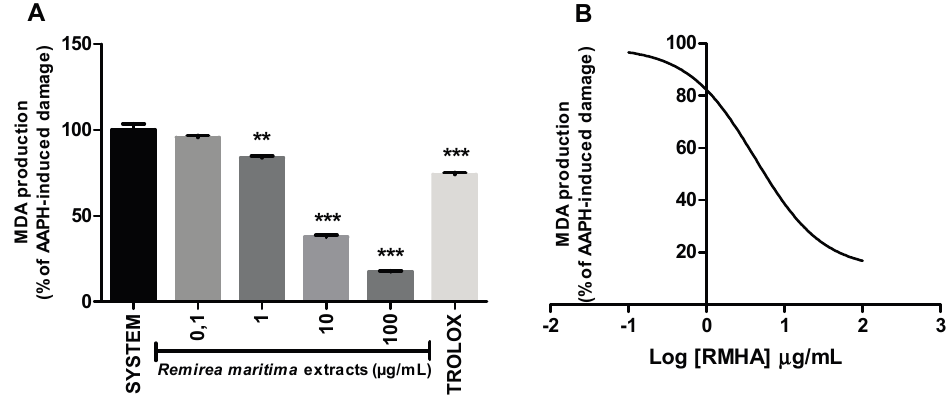
Figure 6. TBARS assay in vitro . ( A ) Effect of different concentrations of RMHA on lipid peroxidation; ( B ) Log IC 50 of RMHA lipid peroxidation activity. Trolox ® (75 µg/mL) was used as standard antioxidant. Bars represent mean ± SEM. ** p < 0.01, *** p < 0.001 (1-way ANOVA followed by Tukey’s multiple comparison post hoc test).